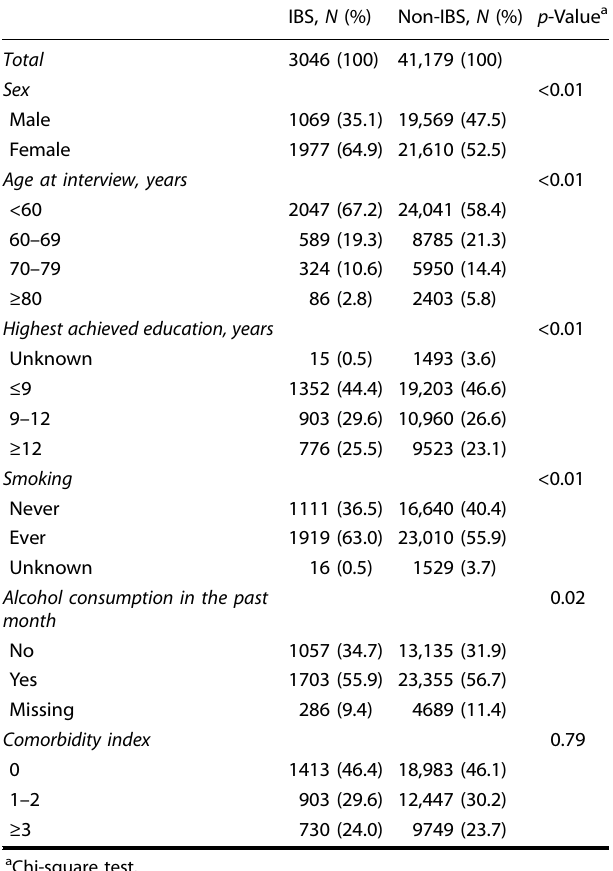
Table 3. Characteristics of the cohort based on SALT Swedish twins, N = 44,225.